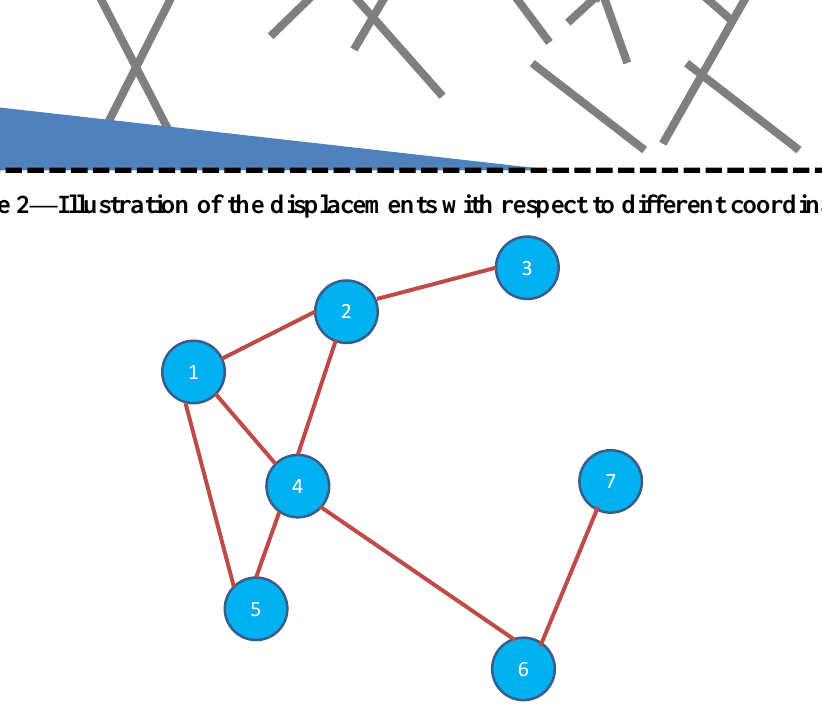
Figure 3—Illustration of endpoints and intersection points as